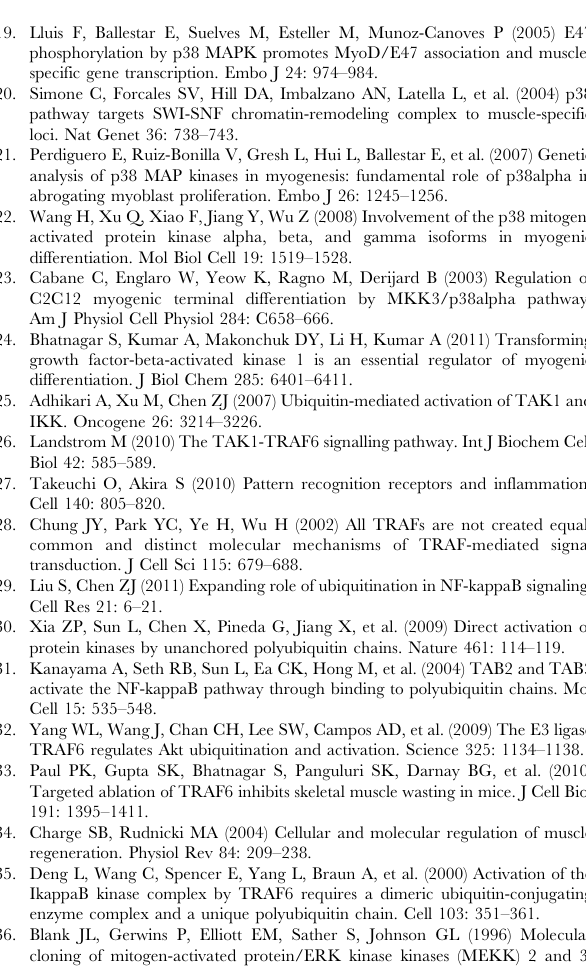
Figure S1 TRAF6 knockdown promoted proliferation of Pax7-positive muscle precursor cells. (A) A Cy3-labeled control siRNA was mixed with liposome and injected into TA muscles. Muscle sections were prepared one day or two days after injection and subjected to fluorescent microscopy. The images were taken with a 4 6 objective. (B) TA muscles of adult mice were injected with CTX followed by treatment with the GFP-siRNA and TRAF6-siRNA as described in the legend of Fig. 6. TA muscles were collected at day 3 after CTX injection. Muscle sections were prepared and subjected to immunostaining for Pax7. The nuclei were counterstained with DAPI. The number of Pax7- positive cells was calculated from five different microscopic fields and the results were presented as mean + s.d. (C, D) Primary myoblasts were transfected with either the GFP-siRNA or TRAF6-siRNA. Twenty-four hours after transfection, cells were either left untreated (C) or treated with BrdU (D) for 1.5 hour before fixation. Cells were then subjected to immunostaining for Pax7, MyoD, and BrdU. The percentage of the Pax7-positive cells and the BrdU-positive cells was calculated as the ratio of the number of Pax7-positive nuclei (C) and BrdU-positive nuclei (D) over that of DAPI-positive nuclei. Cells from five different microscopic fields were counted and the results were presented as mean + s.d.